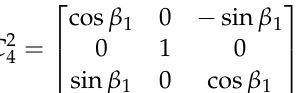
Figure 6. The double optical coupling principle of the light paths of the reflectors. According to Snell’s law of reflection, when a reflector rotates for an angle β , its LOS rotates for an angle β 1 . Accordingly, the geometrical relationship between the two angles is: